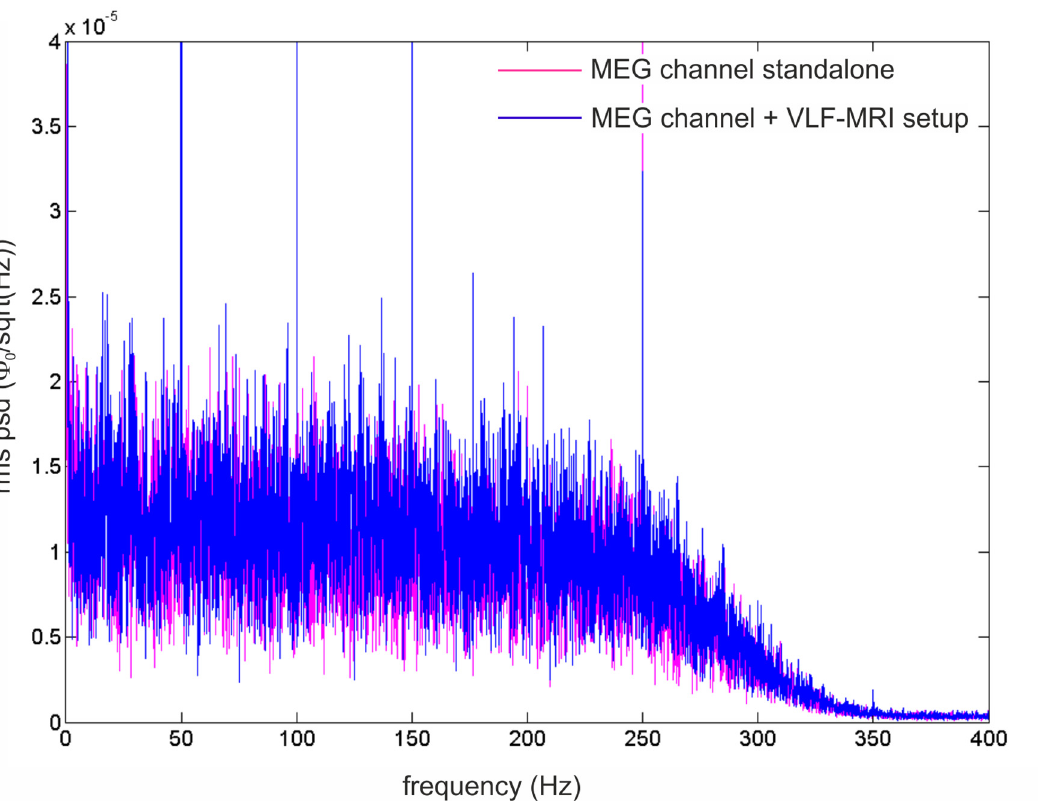
Fig 4. Rms PSD (root mean square power spectrum density) of a MEG channel (band-pass filtered at 0.16 – 270 Hz and sampled at 1024 Hz, ϕ 0 is flux quantum = 2.07 − 15 Wb) obtained when the MRI set-up (magnet and RF coils) is placed in the measurement position (blue rms PSD) and when it is placed at about 2 m from the MEG channel (pink rms PSD). The effect of the MRI setup is limited to a 3% increase of the mean white noise. The 50 Hz peaks (and harmonics) are present in both conditions and are not modulated by the MRI setup in the measurement position.